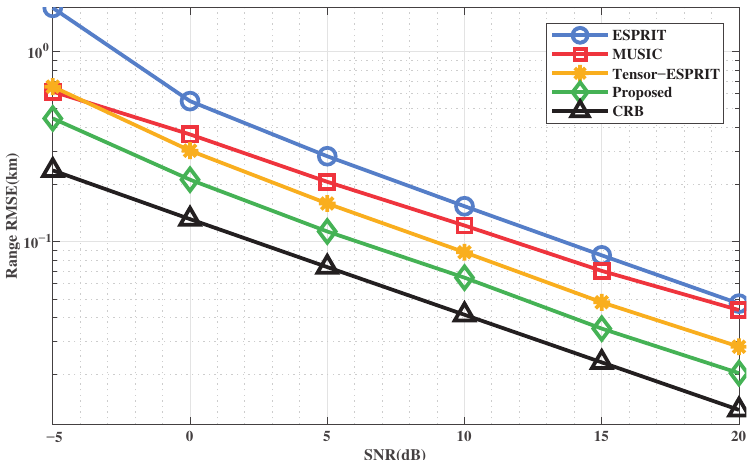
Figure 5. RMSE of DOA estimation versus SNR